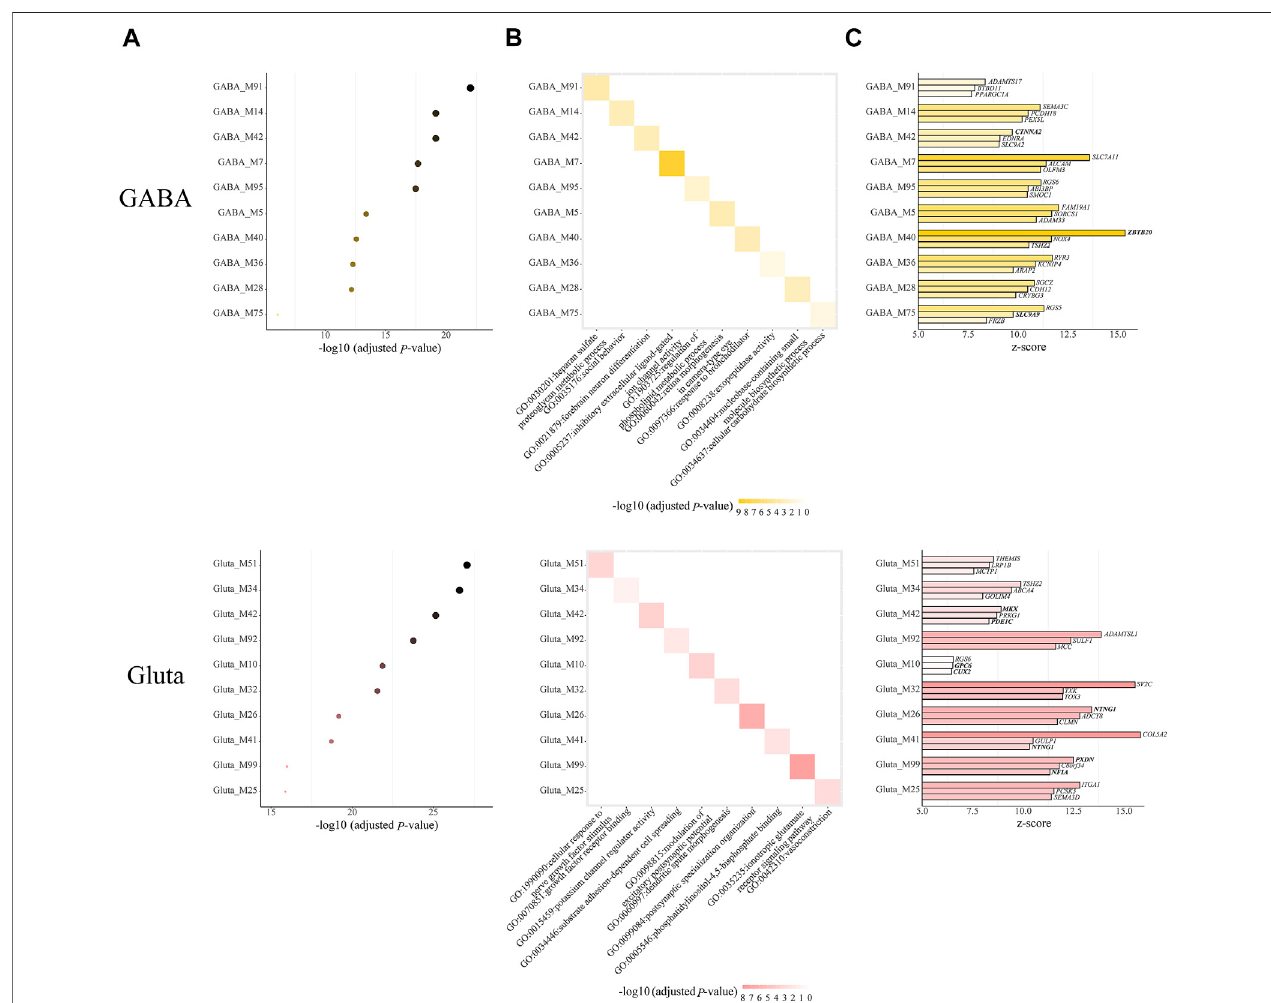
FIGURE4| Cell-type-speci fi cASD-associatedmodules,whichhavebothmodule-speci fi candcelltype-speci fi cGOterms,alongwith (A) theirBonferroni-adjusted hypergeometric test p-values, (B) top one enriched GO term, and (C) top three z-score genes. The SFARI ASD genes are bold. The Bonferroni-adjusted p-values were derived from the hypergeometric tests using module genes and ASD